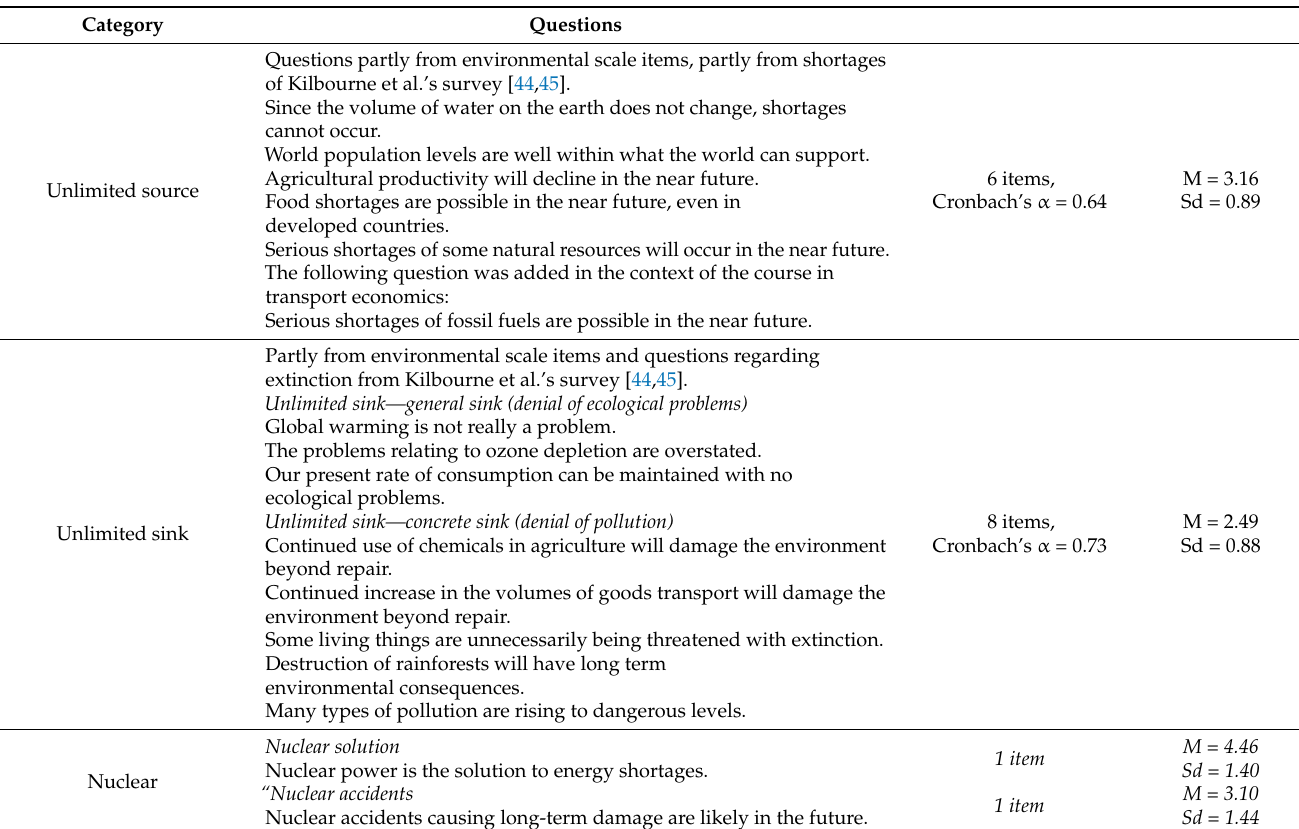
Table A2. Limited resources, irreversible damage, and nuclear—survey questions and